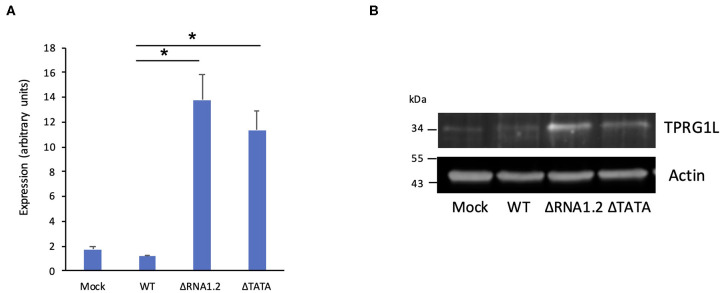
TPRG1L transcript and protein levels in RNA1.2 mutant-infected cells. HFFF2 cells were infected with WT, ΔRNA1.2, or ΔTATA at MOI = 5. At 72 h p.i., RNA and protein were harvested and analyzed. (A) RT-qPCR data from three independent experiments, each with duplicates. Standard errors are marked by error bars. Significant differences are marked by asterisks (p < 0.001, paired t-test; p < 0.05, Wilcoxon matched-pairs signed rank test). (B) Immunoblotting data from one of three independent experiments.